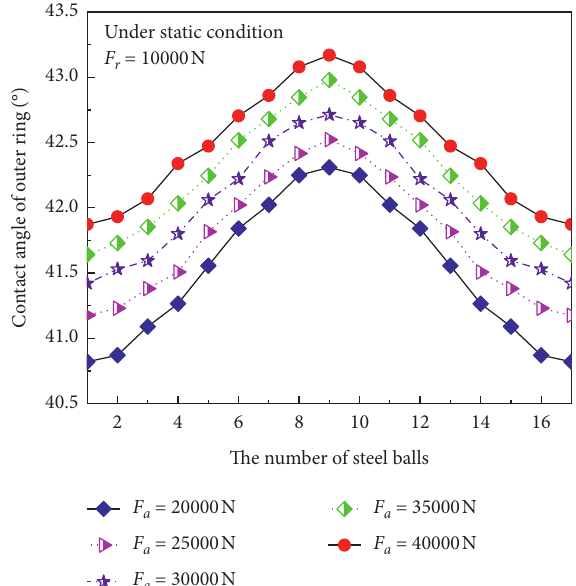
Figure 17: Change curve of actual contact angle with ball position under different radial loads.